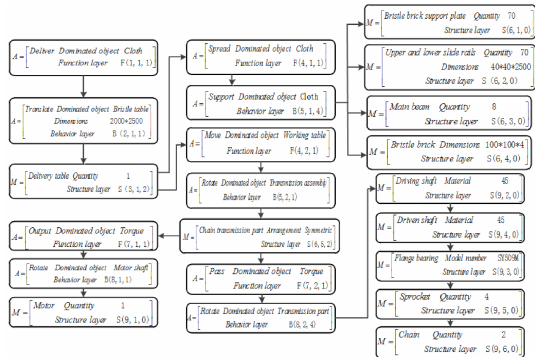
Figure 7. Multi-layer FBS decomposition of delivery system of cutting machine.